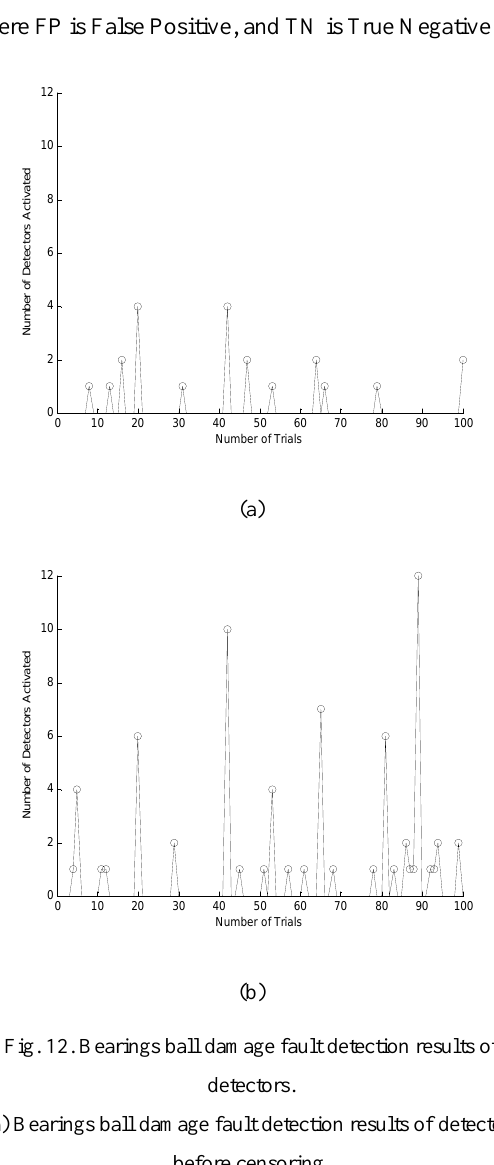
Fig. 12. Bearings ball damage fault detection results of